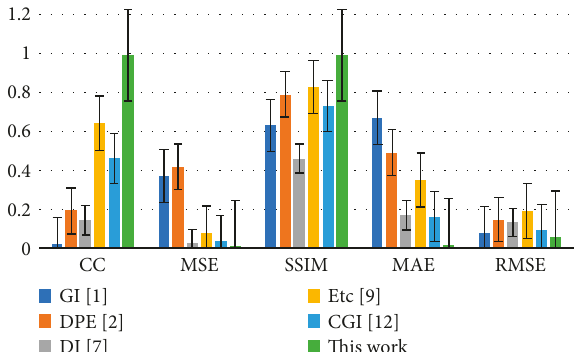
Figure 5: Comparative performance of the proposed method.